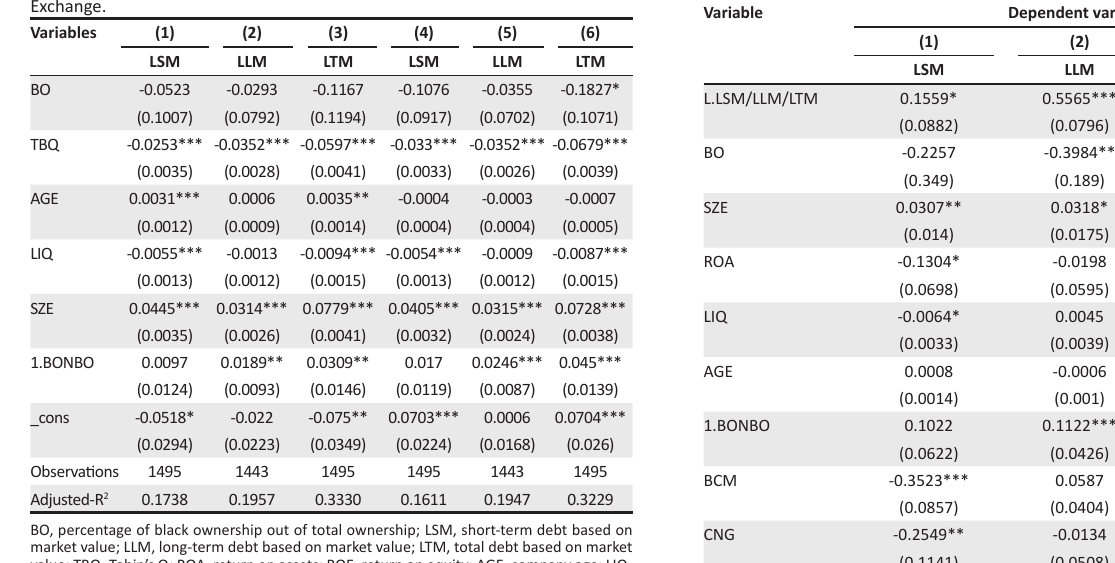
TABLE 6: The effect of black ownership on capital structure (generalised method of